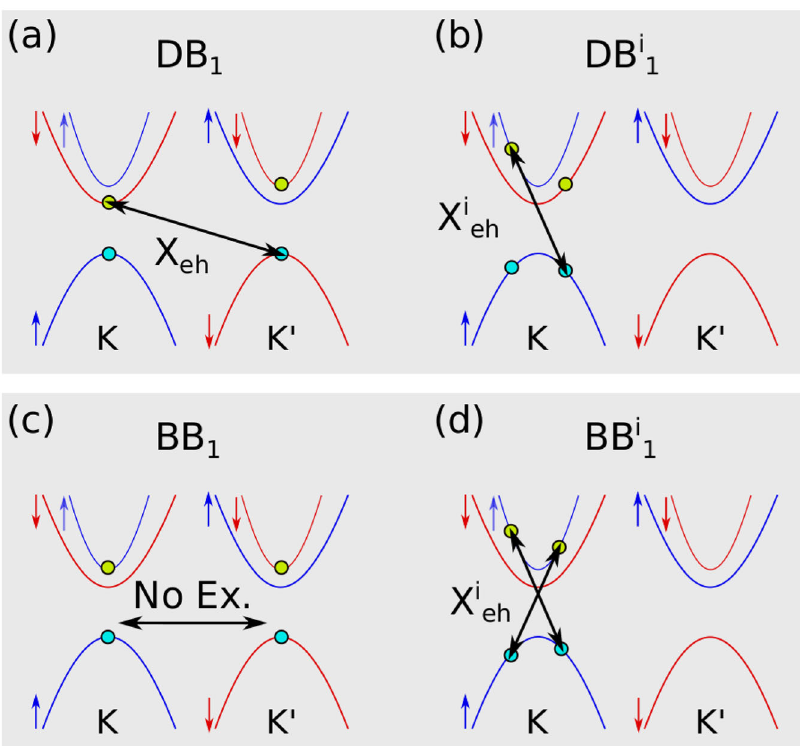
Fig. 3 Schematic comparison of electron – hole exchange interactions entering the formation of inter- and intravalley con fi gurations. In a and b , the comparison is between the intervalley ( a ) and intravalley ( b ) con fi gurations for the dark – bright DB 1 state. In c and d , the same comparison is shown for the bright – bright BB 1 state. In all these plots, only the interactions that are present in one con fi guration and not the other are shown for comparison. Moreover, we neglect the electron – electron exchange interaction in this fi gure. The positions of electrons and holes in the intravalley con fi guration are exaggerated for